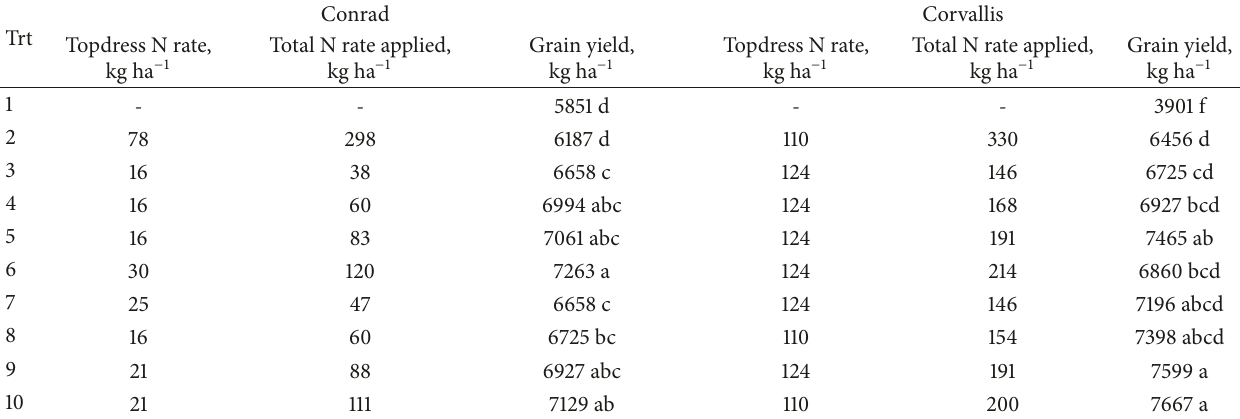
Table 4: Preplant N rate, topdress N rate, topdress N source, total N rate applied, and spring wheat grain yield, Conrad and Corvallis, MT, 2012.